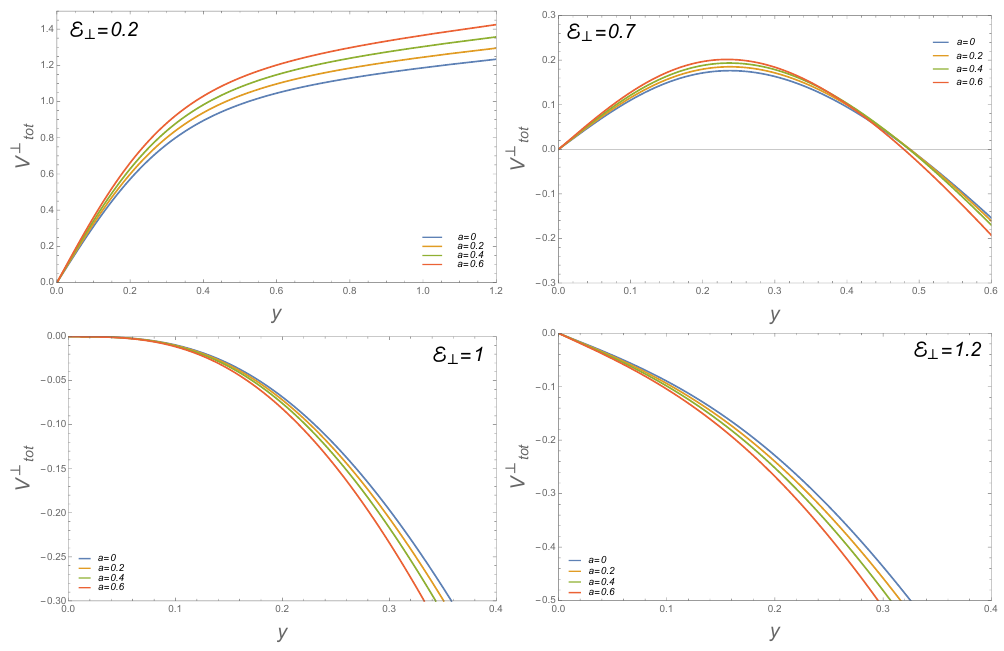
Figure 7 . The holographic potential V ⊥ fixed E ⊥ in the bubble